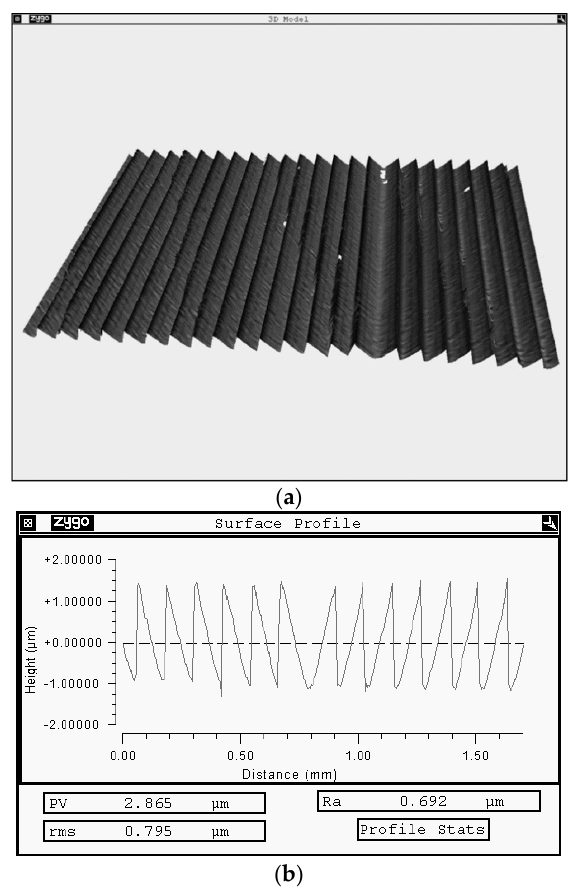
Figure 9. Image of the manufactured blazed grating: ( a ) 3D image of the relief, and ( b ) cross-section of the relief profile.